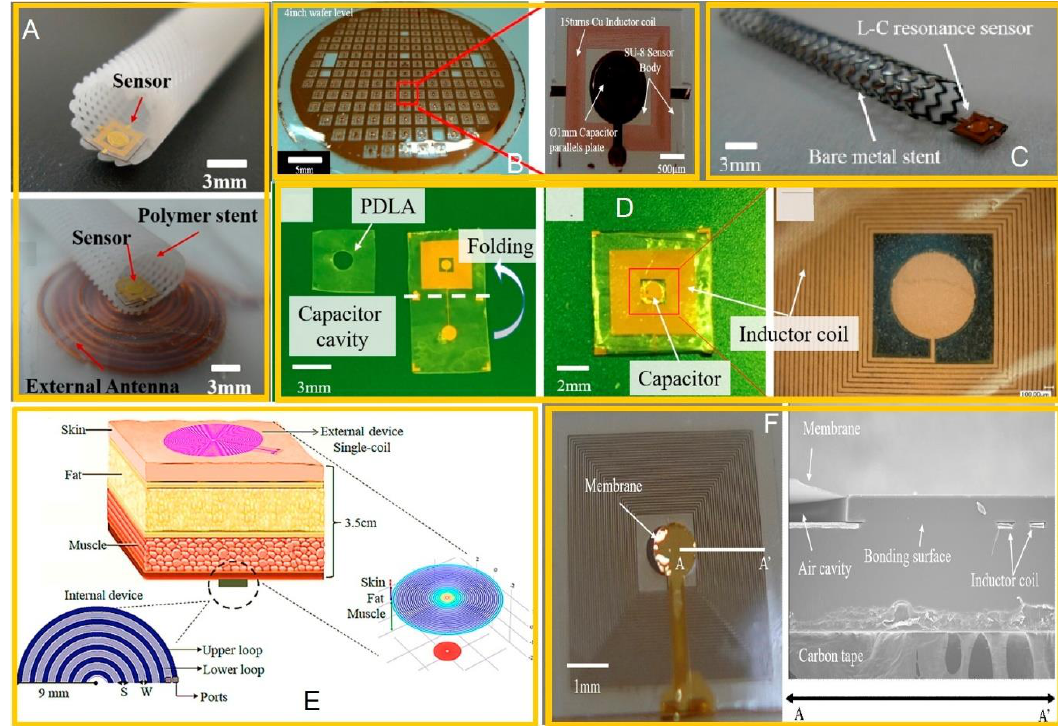
Figure 2. Wireless pressure sensor in micro-electro-mechanical system (MEMS) device: ( A ) Optical images of polymer stents integrated with wireless pressure sensors; ( B ) actual photo images; ( C ) optical image of bare metal stent integrated with the wireless pressure sensor. Reproduced with permission [32], Sensors Open Access; ( D ) fabricated poly(D-lactide) (PDLA)-based wireless pressure sensors. Reproduced with permission [35], copyright 2020, Elsevier; ( E ) scheme showing the inductive coupling across the biological tissue. Reproduced with permission [36], Sensors Open Access; ( F ) fabricated wireless pressure sensor with SEM cross sectional view of the wireless pressure sensor fabricated using a SU-8 thermal pressure bonding technique. Reproduced with permission [34], copyright 2020, Elsevier.